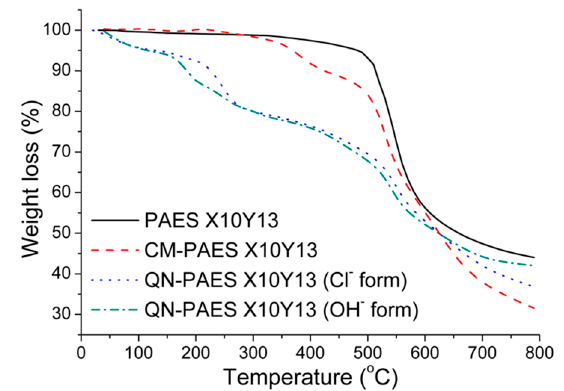
Figure 5. Thermal stability of polymers at heat rate of 10 °C min − 1 .